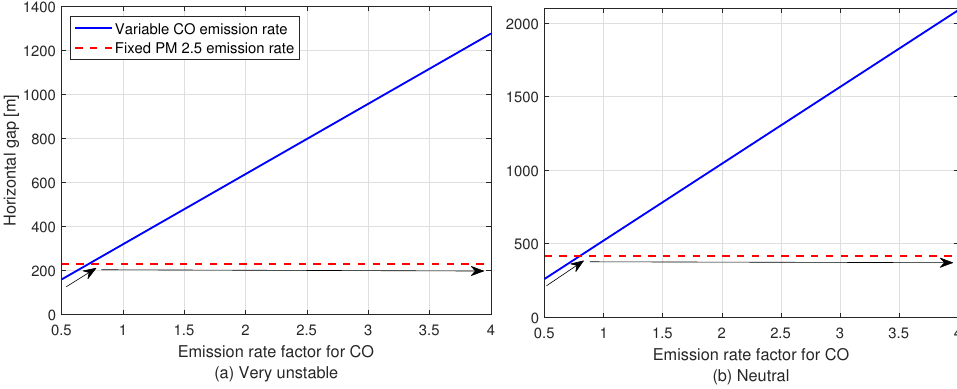
Figure 11. The impact of the CO emission rate on the horizontal gap while keeping the PM2.5 emission rate constant. The black arrow indicates the chosen optimal value of the horizontal gap when the CO pollutant’s rate factor is changed while the PM2.5 pollutant’s rate remains